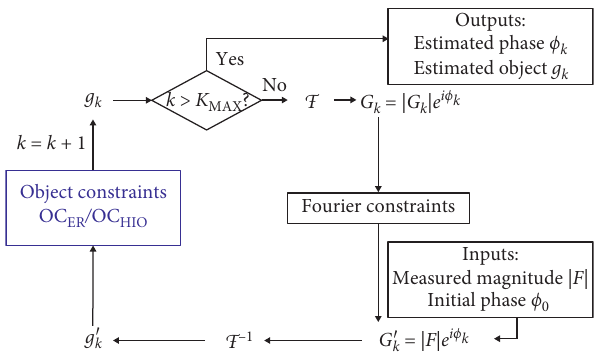
Figure 1: Diagram of the iterative PR algorithm, where the pa- and k represent the maximum number of PR it- rameters K MAX erations and the k th iteration, respectively. The blue block indicates that the ER and HIO algorithms use different activations to force the estimated object to satisfy object